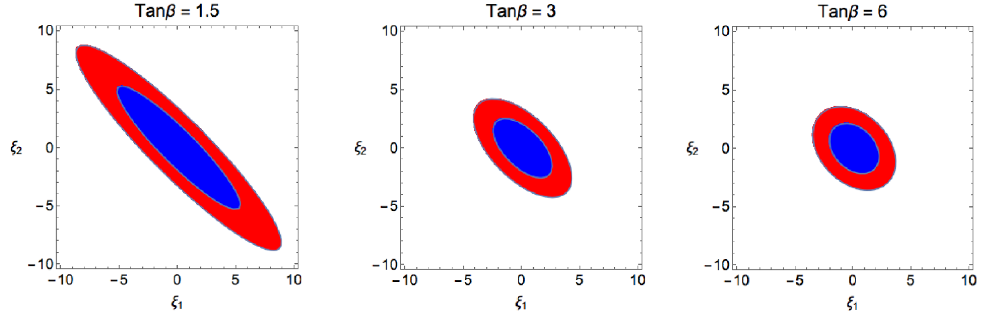
Figure 6 . Theoretically allowed (cid:24) 1 - (cid:24) 2 parameter space for di(cid:11)erent values of tan (cid:12) . The blue (red) region is for (cid:3) = 3(5) TeV.